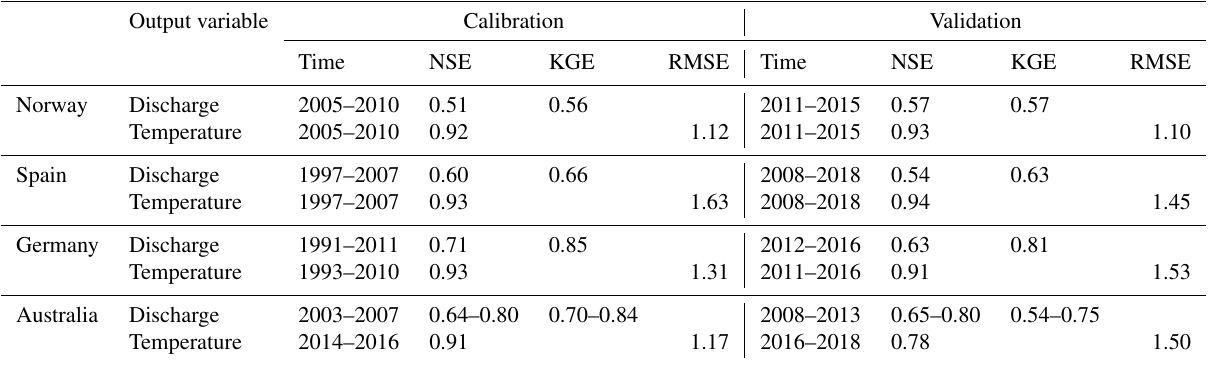
Table 4. Verification statistics of the catchment and lake model for each case